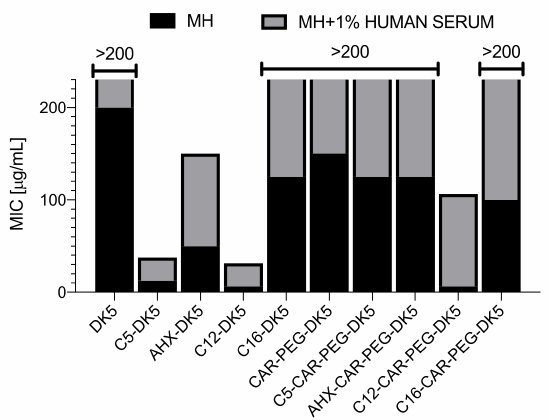
Figure 4. The comparative analysis of MICs established for S. aureus PCM 2054 strain in the presence or absence of 1% normal human serum. The black columns correspond to the results obtained in standard Mueller-Hinton broth, while the grey columns cover the results obtained in Mueller-Hinton broth supplemented with 1% of normal human